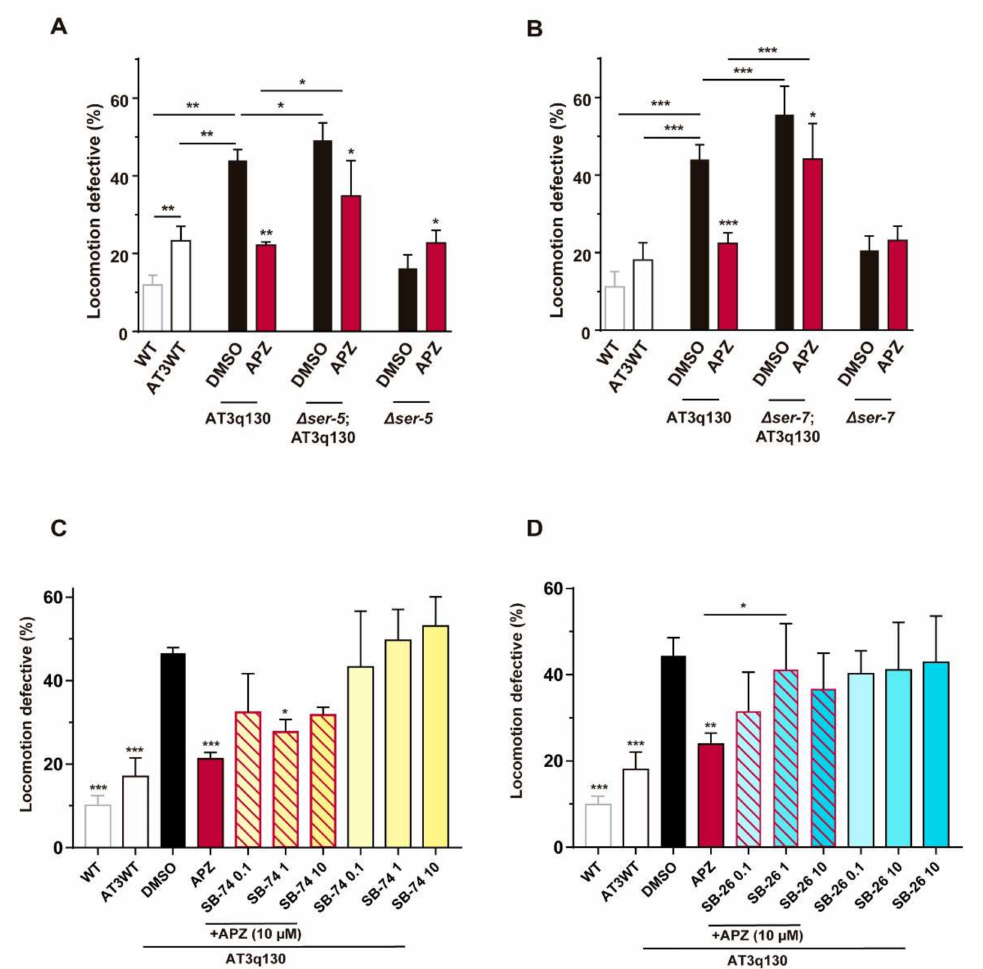
Figure 5. SER-5 5-HT6R and SER-7 5-HT7R partially contribute to aripiprazole-mediated amelioration of AT3q130 motor defects. Aripiprazole (10 µ M) treatment of C. elegans null strains for ( A )